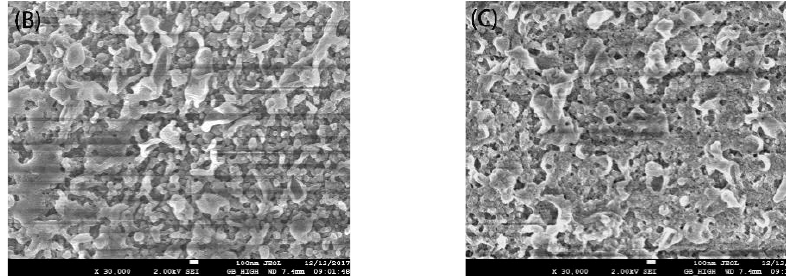
Figure 6. The SEM images of the surface morphology of ( A ) PA membranes, ( B ) PA and MWCNT’s nanocomposite membrane, and ( C ) PA and 12-chloro-12-oxododecanedioic acid-methyl ester (CH 2 OCOC 12 H 23 O 3 ) modified MWCNT’s nanocomposite membrane.